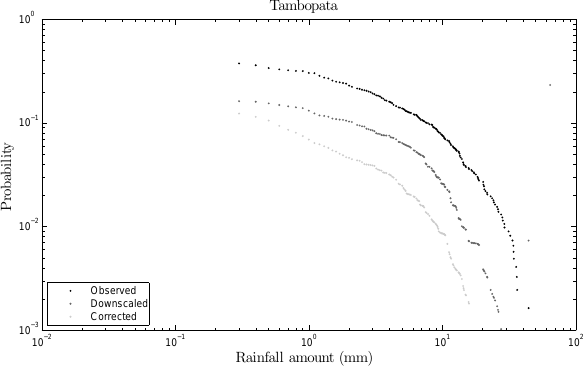
Figure 22. Exceedance probability of the Tambopata station dur- ing the dry season over an 8-year period. Comparison of observed, generated and corrected rainfall for the Tambopata